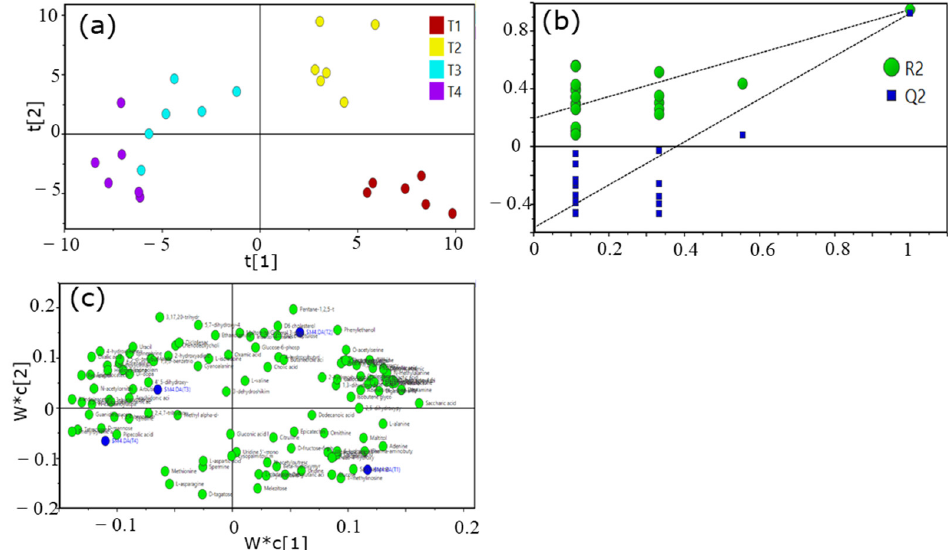
Figure 4. Score plot ( a ), permutation test ( b ), and loading plot ( c ) from a partial least squares discriminant analysis (PLS-DA) of metabolites in young tea shoots under different fertilization treatments analyzed by gas chromatography−mass spectrometry (GC-MS).